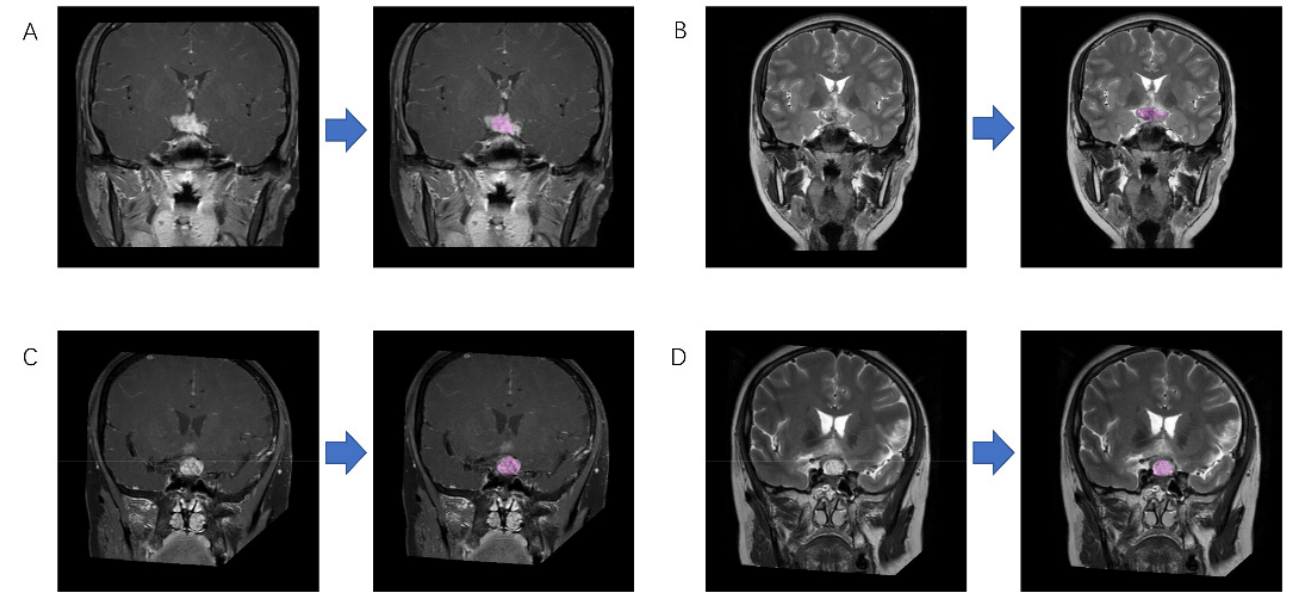
Figure 2. Example of region of interest drawing. This figure shows magnetic resonance imaging of ( A ) germinoma on contrast-enhanced T1WI; ( B ) germinoma on T2WI; ( C ) craniopharyngioma on contrast-enhanced T1WI; ( D ) craniopharyngioma on T2WI before and after drawing.